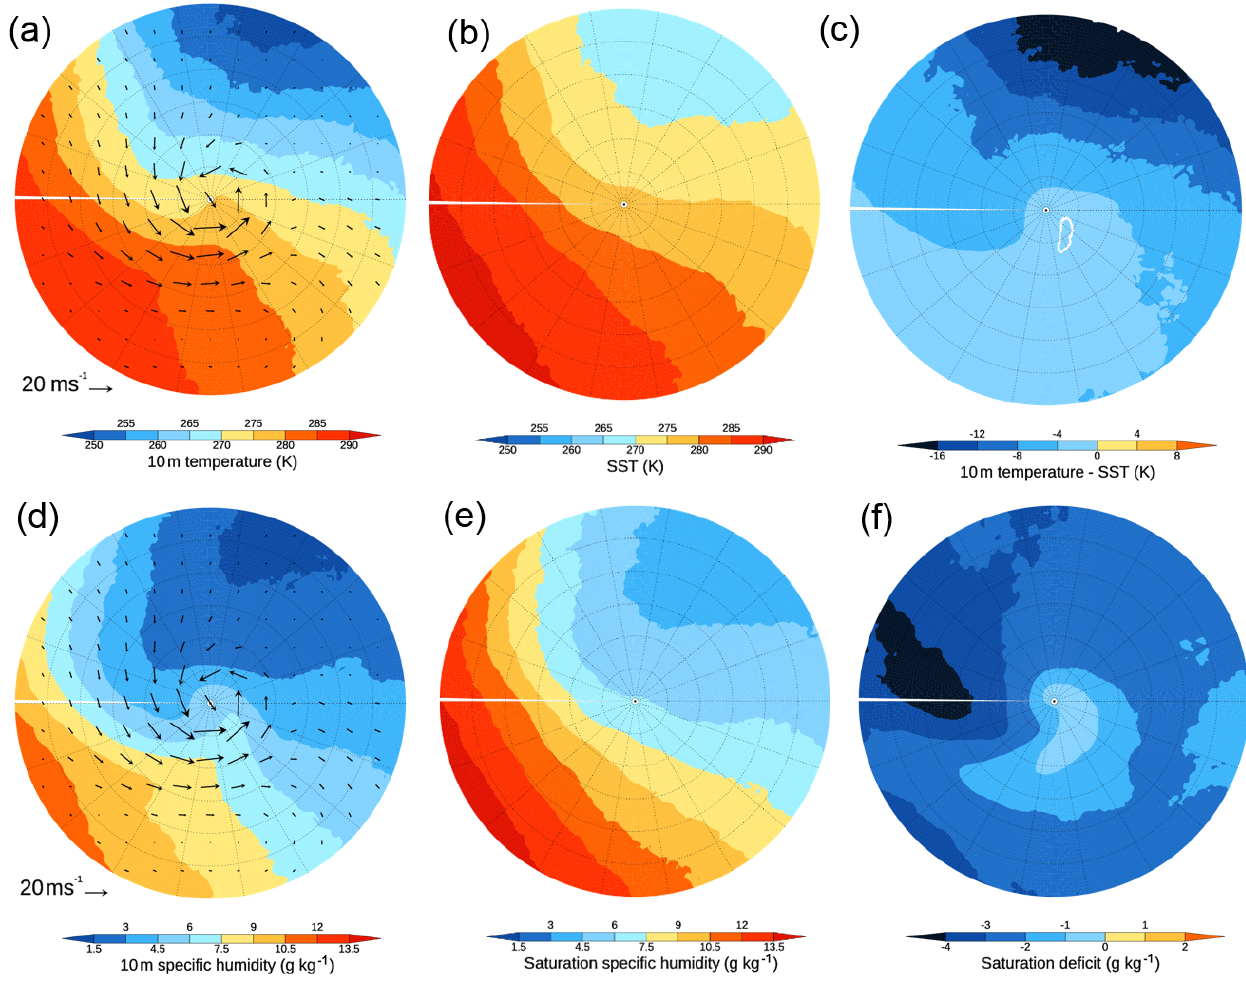
Figure 6. Cyclone-centred fields at maximum intensity. (a) 10m air temperature (K), (b) SST (K), (c) 10m temperature − SST (white contour is − 0 . 4K; K), (d) 10m specific humidity (gkg − 1 ), (e) saturation humidity of SST (gkg − 1 ), and (f) 10m specific humidity − saturation humidity of SST (gkg − 1 ). Panels (a) and (d) overlaid with 925hPa